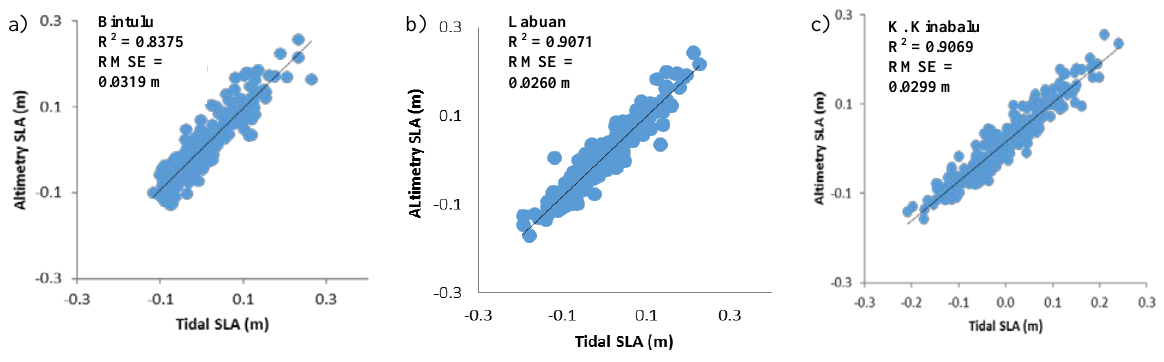
Figure 8. The altimetry and tidal sea level correlation analysis at the Bintulu (a), Labuan (b) and K. Kinabalu (c)